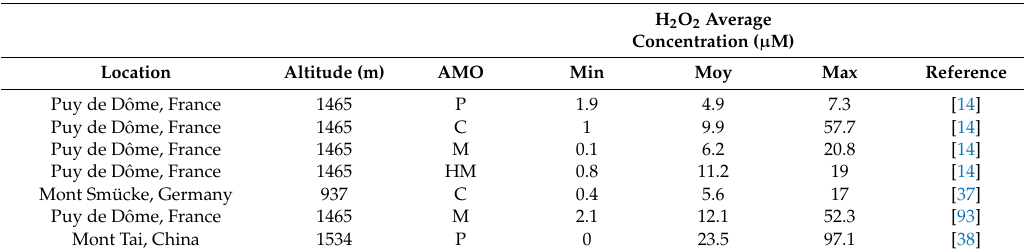
Table 1. Average for H 2 O 2 in cloud water sampled at di ff erent